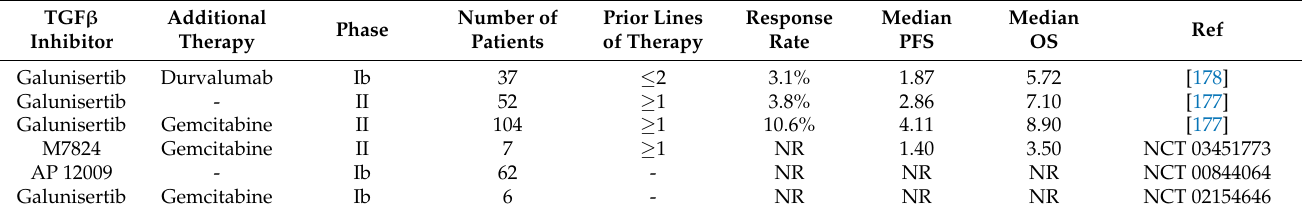
Table 1. Results of select clinical trials exploring TGF β inhibitors in PDAC patients. TGF β